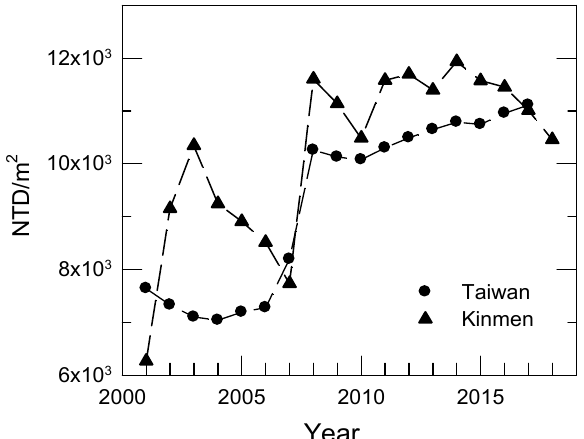
Figure 9. Initial capital cost in terms of the area of solar collectors in Taiwan and Kinmen County.